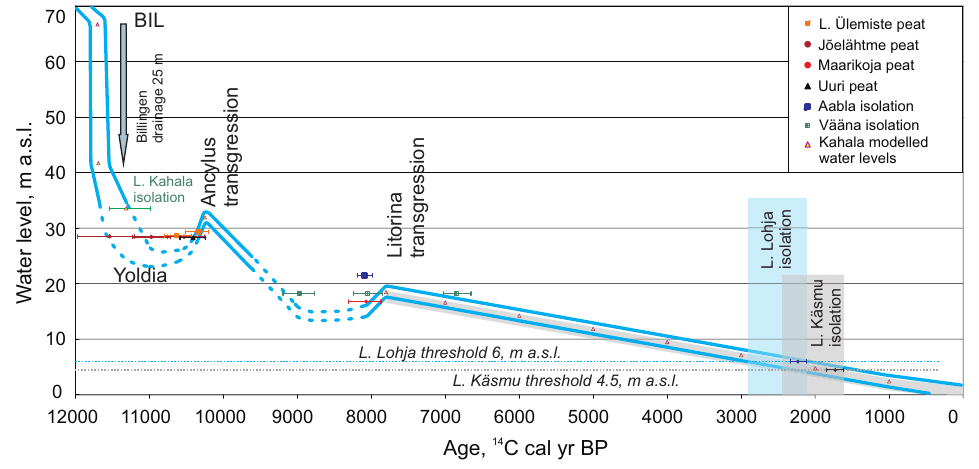
Fig. 5. Shoreline displacement curve for the study area. For the Lohja site blue lines mark the modelled possible minimum and maximum water level changes and for the Käsmu site, the grey area (shown only from the Litorina Sea transgression up to today) marks the modelled possible range of the water level. The reconstruction considers errors in both, modelled water levels ( ! 1 m) and ages. The blue and grey boxes show the possible isolation age according to modelled water level against the isolation age according to the AMS 14 C dates (black circles with error